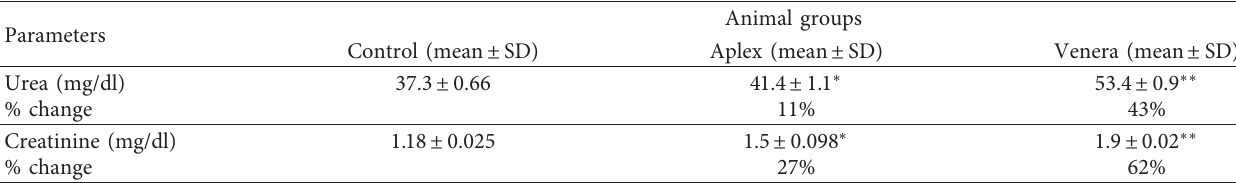
Table 6: Kidney function enzymes in sera of control and treated animal groups.